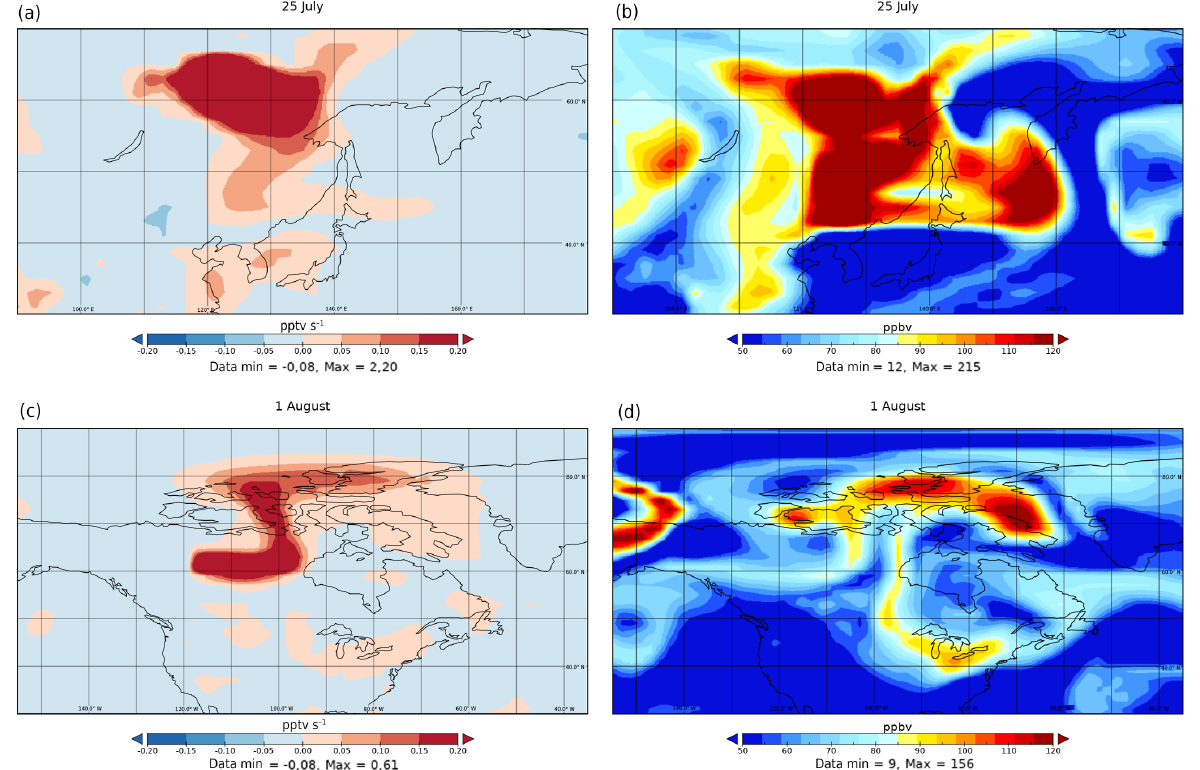
Figure 9. (a, c) Production of O 3 (in pptvs − 1 ) and (b, d) concentrations of O 3 (in ppbv) on 25 July over Siberia (a, b) and 1 August 2014 over North America (c, d) at 5.5km in altitude simulated by the MOCAGE